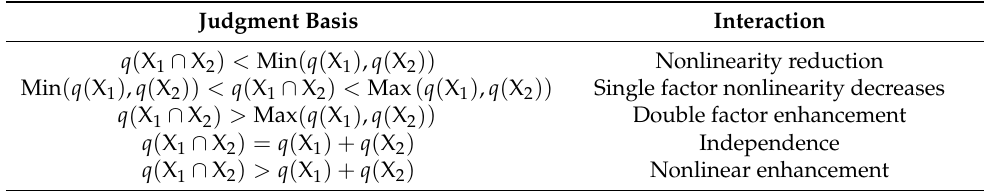
Table 2. The interaction categories of two factors and the interactive